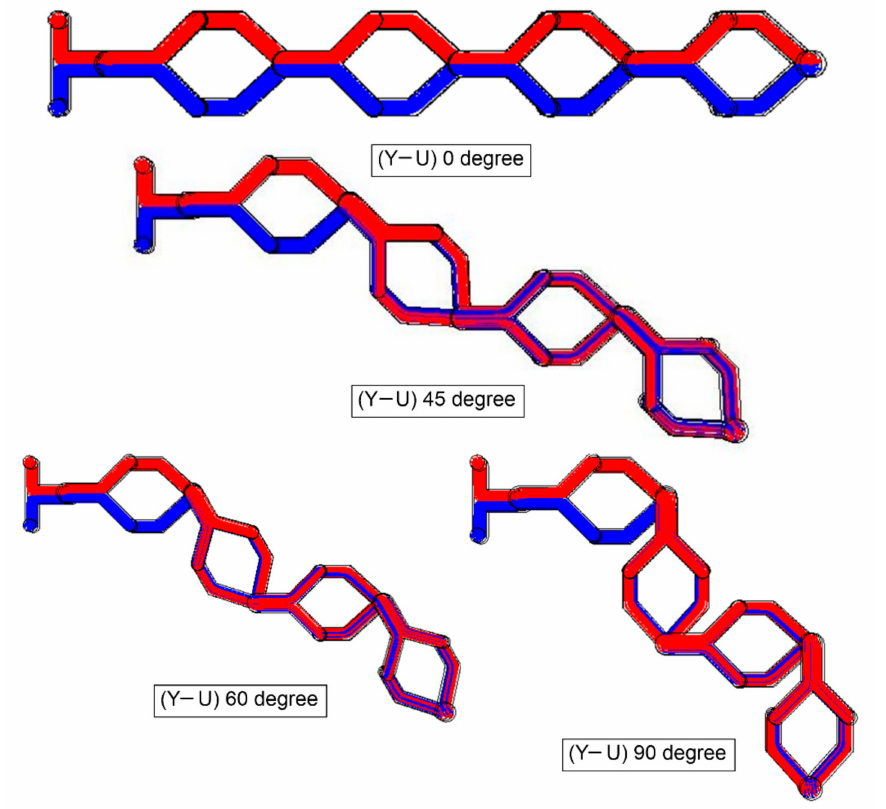
Figure 7. Path lines inside the mixers at different angles at Re = 50. Red and blue colors represent two input